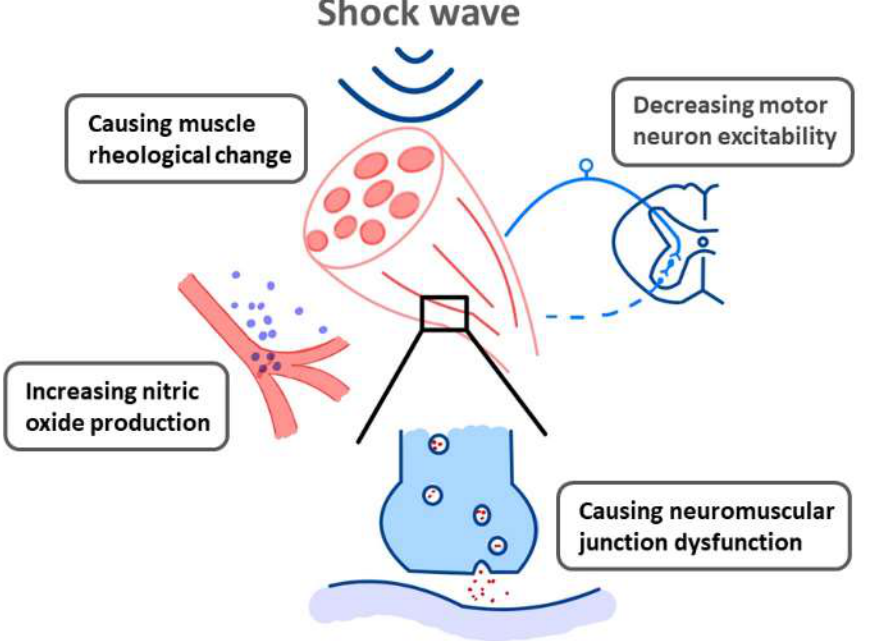
Figure 2. Proposed mechanisms of shock wave effects in spasticity, according to Xiang et al. [14], Moon et al. [15], Kenmoku et al. [16], and Manganotti et al. [17].